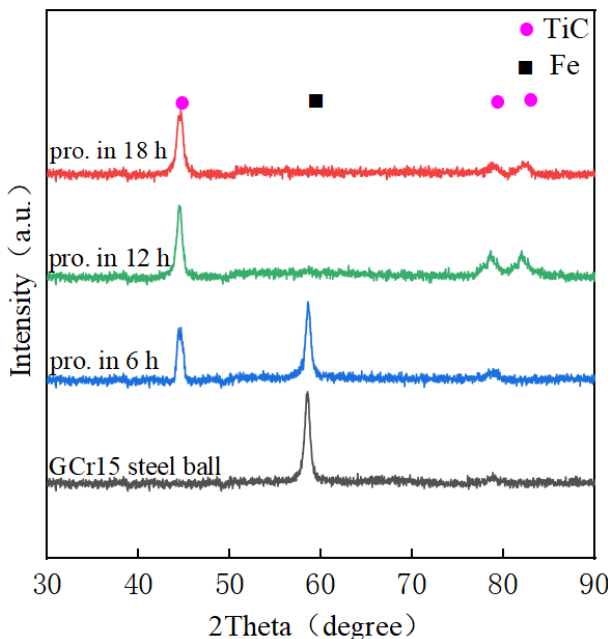
Figure 5. XRD patterns of TiC coatings on GCr15 steel balls after 6 h, 12 h and 18 h milling durations.